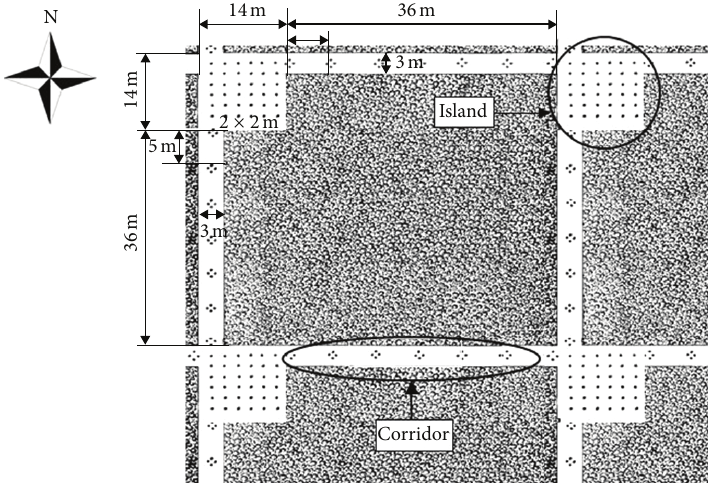
Figure 1: “Island and corridor” planting method (after Hattori et al. 2009